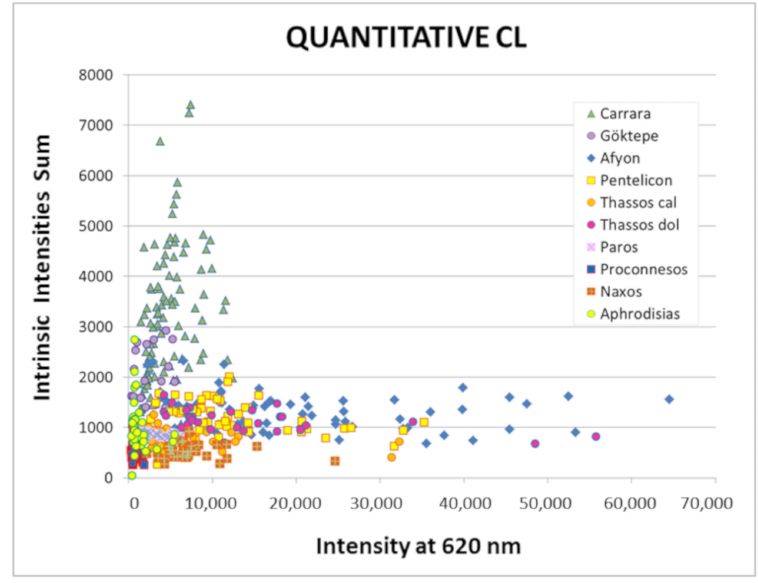
Figure 5. General quantitative CL diagram for the main classical